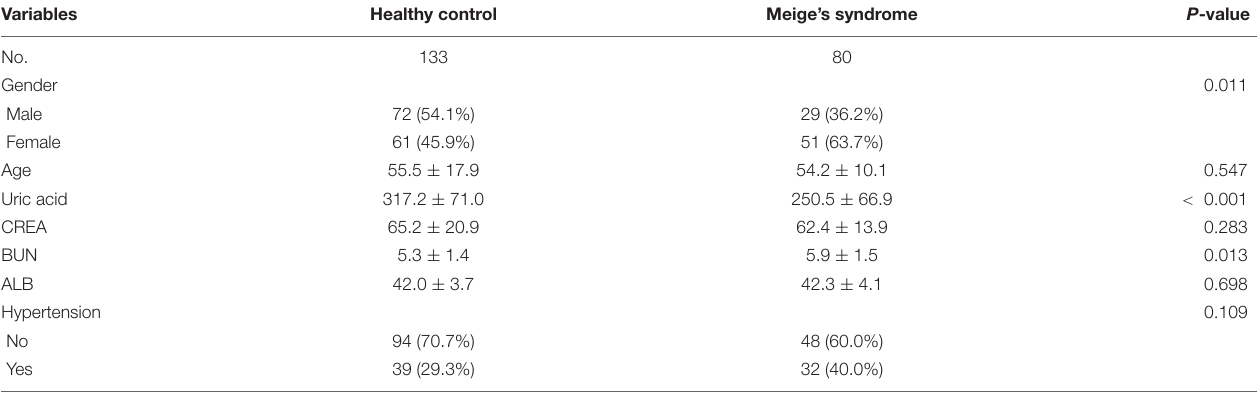
TABLE 1 | Characteristics of the patients with Meige’s syndrome and healthy controls.